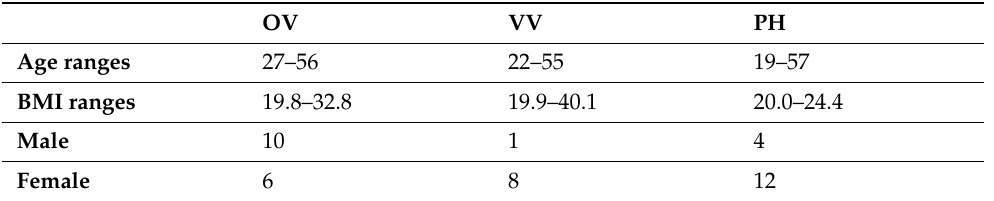
Table 1. General participant information. Listed below are the age ranges, BMI ranges, and sex ratio for all groups.